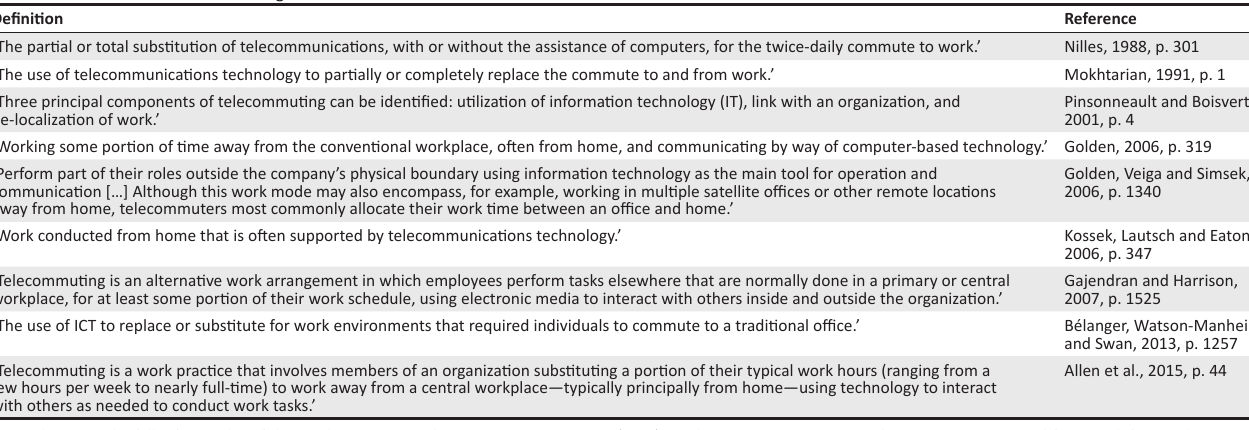
telecommuting, ordered by date of